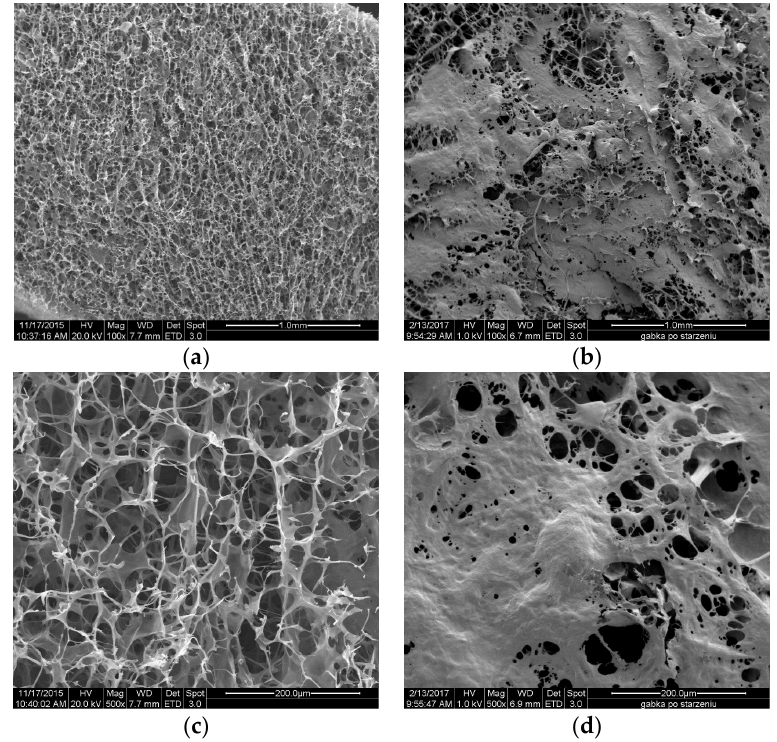
Figure 13. SEM microphotographs of ( a ) foam before accelerated ageing at magnification 100×; ( b ) foam after accelerated ageing at magnification 100×; ( c ) foam before accelerated ageing at magnification 500×; and ( d ) foam after accelerated ageing at magnification 500×.